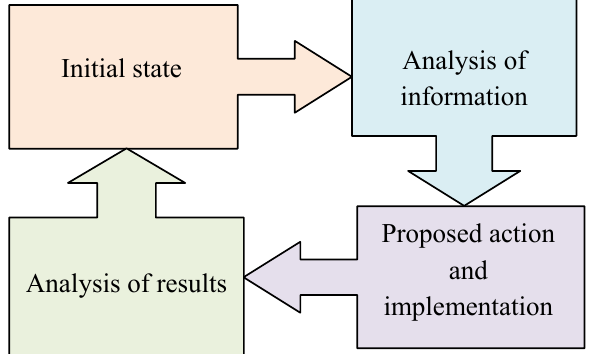
Figure 2. Methodology for increasing the energy efficiency of an Heating, Ventilation and Air-Conditioning (HVAC)